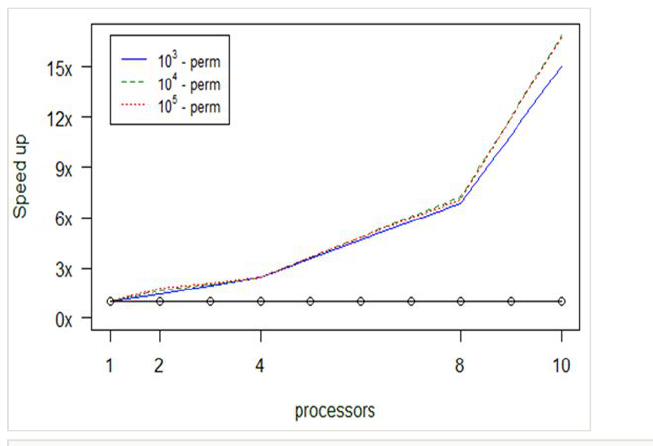
Figure 19. Computational results about optimization in mantel's performance, depending on permuations and number of processors (np), for large